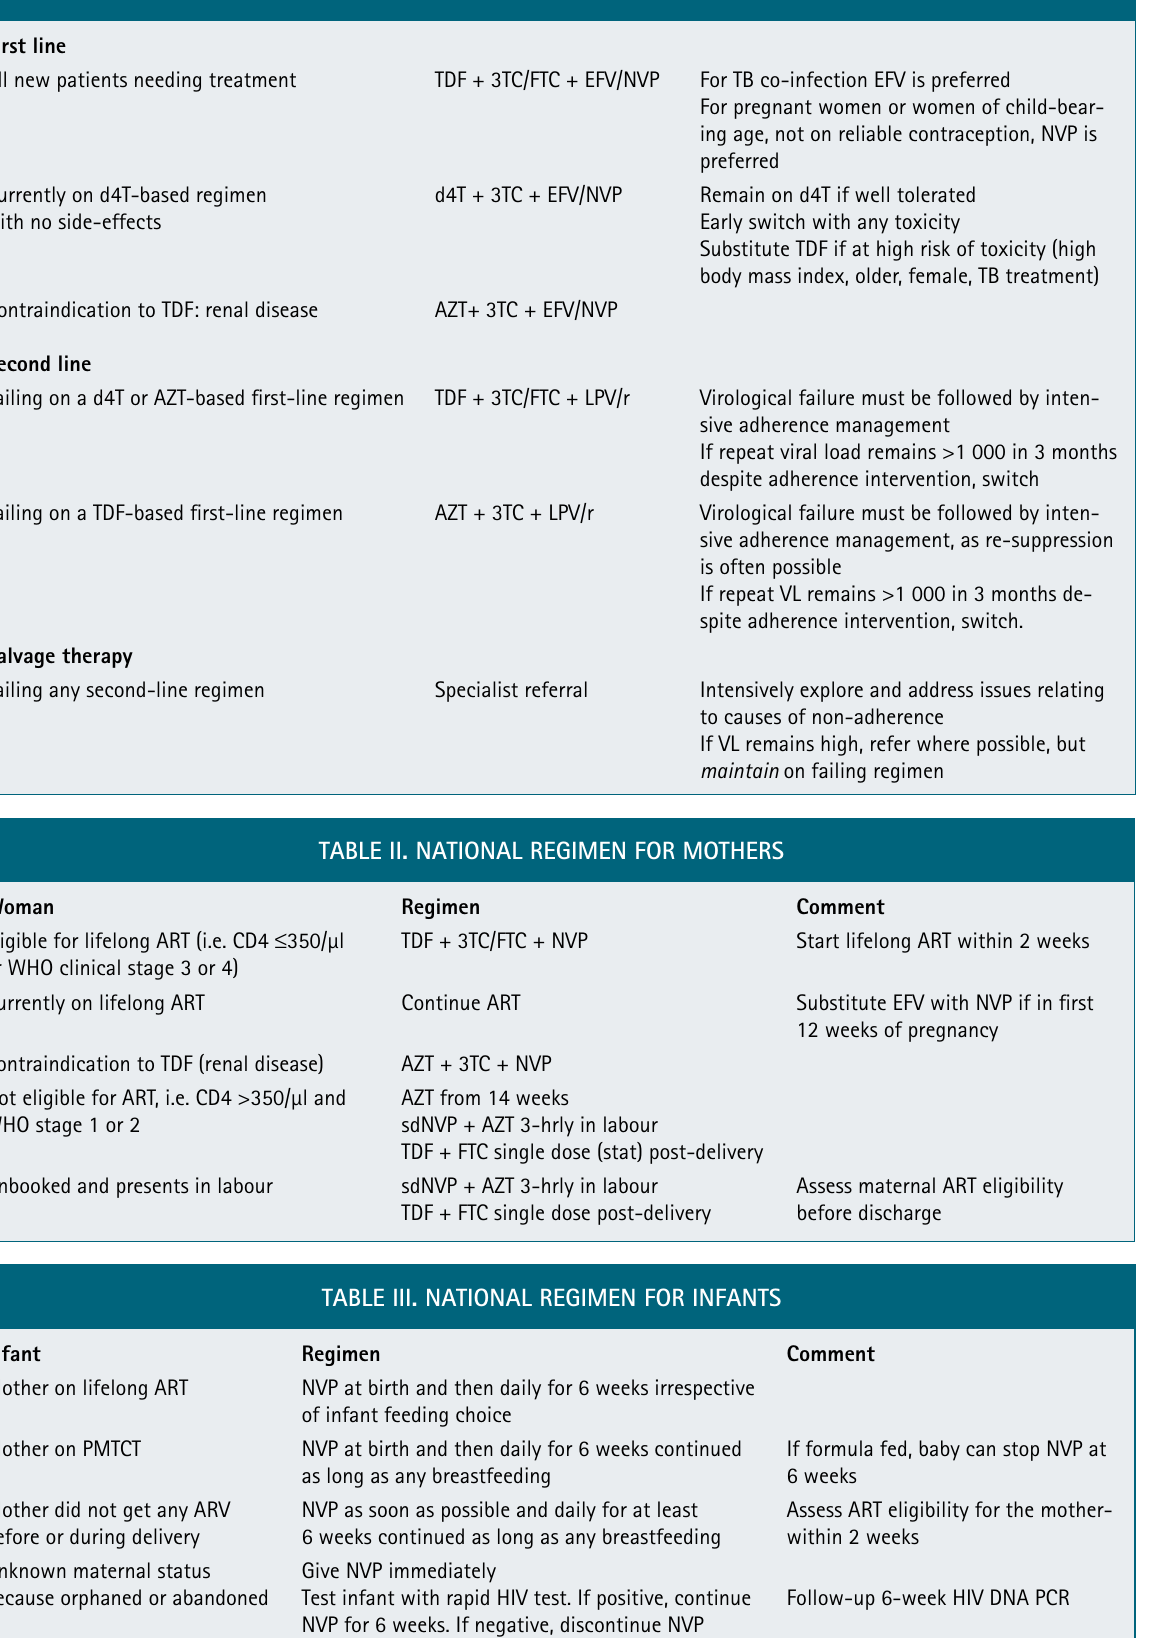
TABle i. nATiOnAl RegiMens FOR CHildRen And